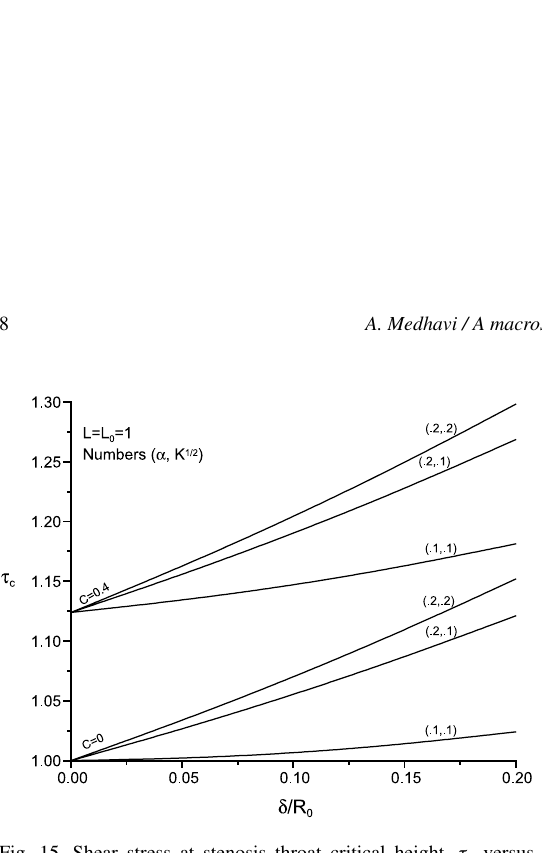
Fig. 15. Shear stress at stenosis throat critical height, τ c versus stenosis height, δ/ R o for different C, α and k 1 / 2